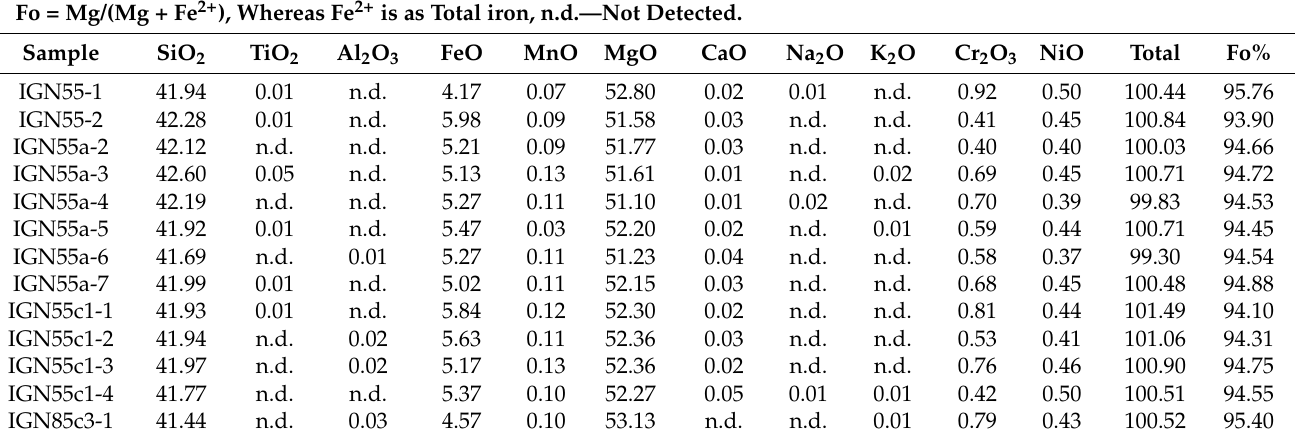
Table 4. Representative analyses of olivine (wt%) included in the high-Cr chromitite of Sebuku Island. Fo = Mg/(Mg + Fe 2+ ), Whereas Fe 2+ is as Total iron, n.d.—Not